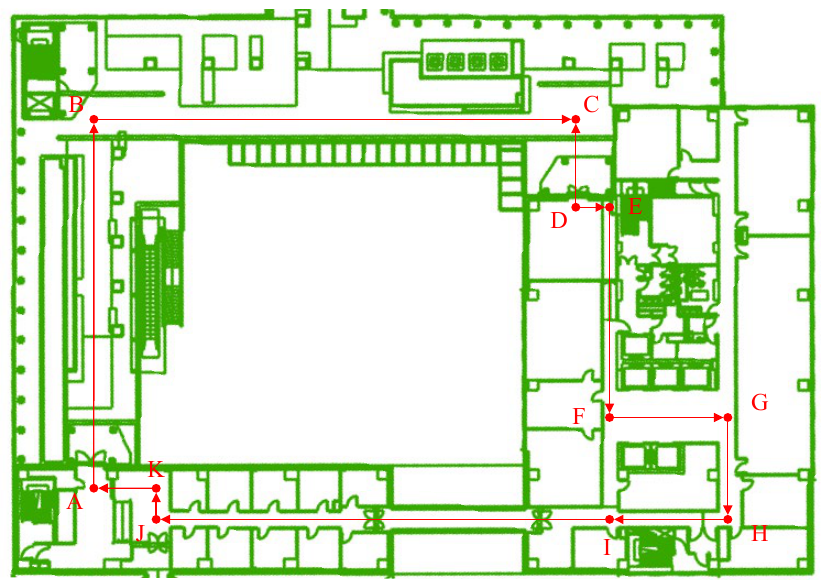
Figure 4. Test Walking Route of Inertial Odometry.